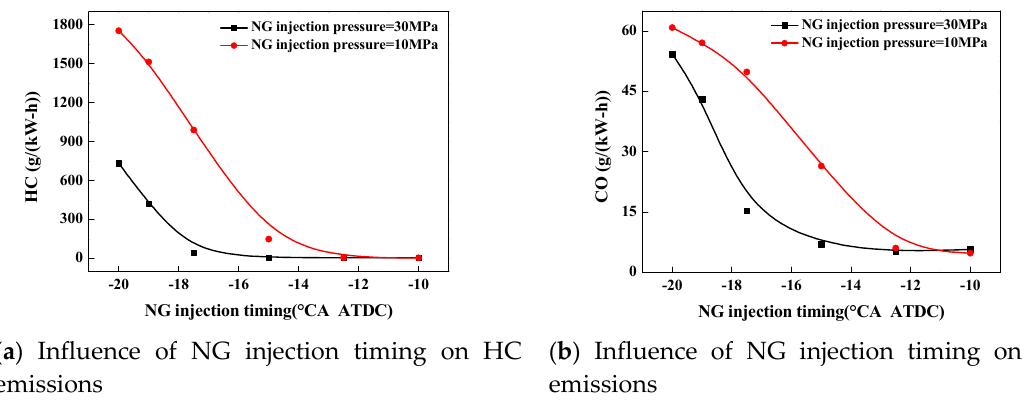
Figure21. Figure 21. Changes of hydrocarbon (HC) and carbon monoxide (CO) emissions with NG injection timing.